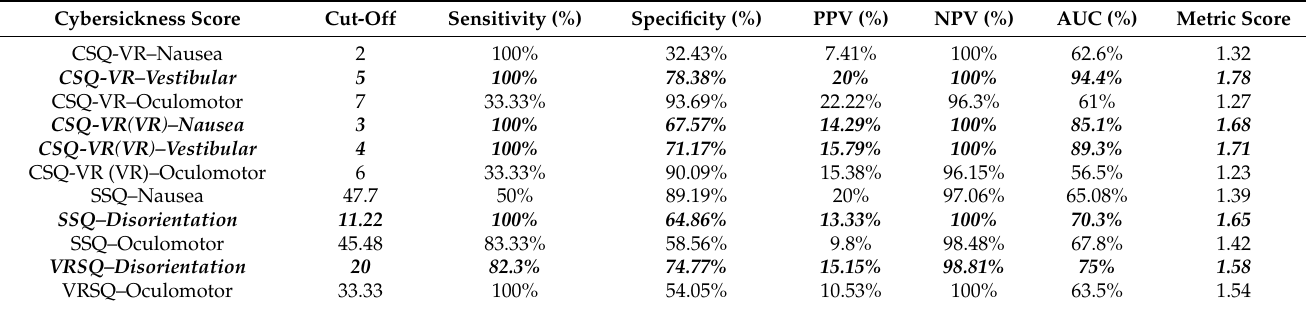
Table 8. Psychometric Properties of the CSQ-VR, SSQ, and VRSQ Vestibular/Disorientation Scores in detecting Motor Speed